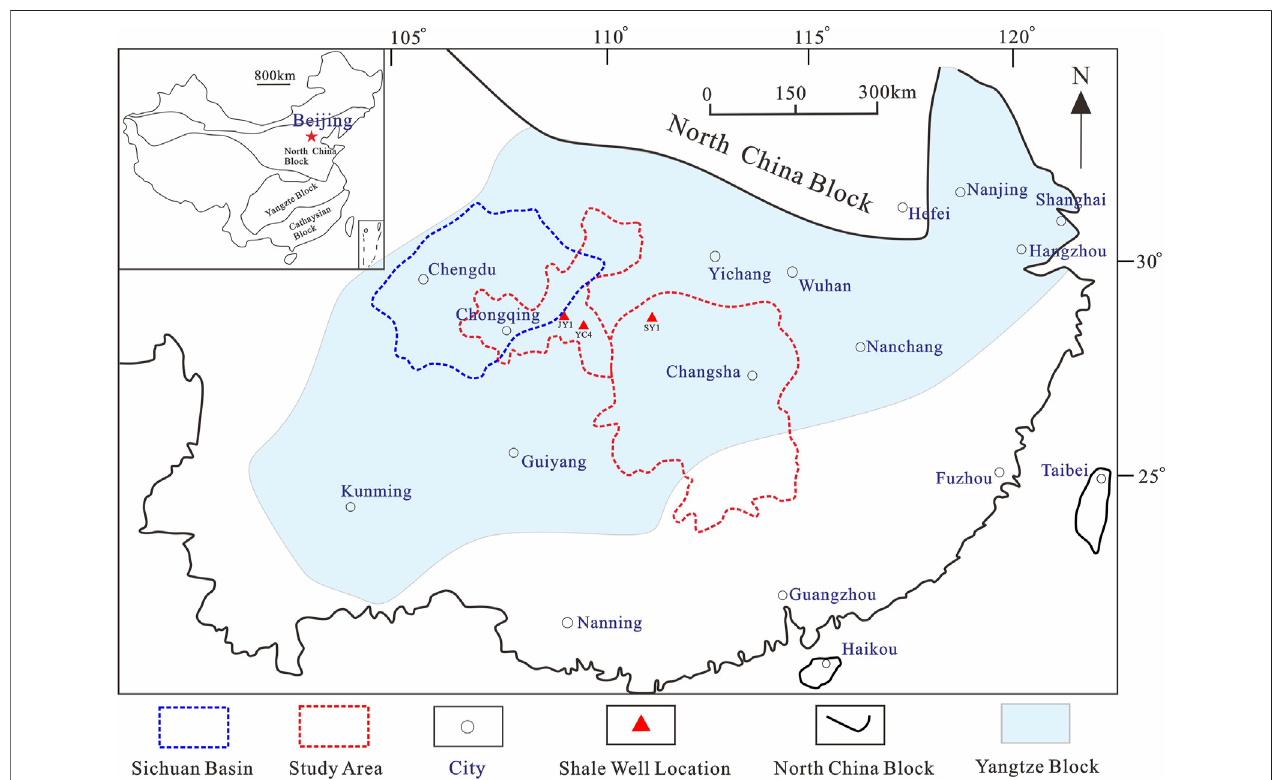
FIGURE 1 | The study areas and the well locations of the Longmaxi shale in Chongqing and Hunan, South China.